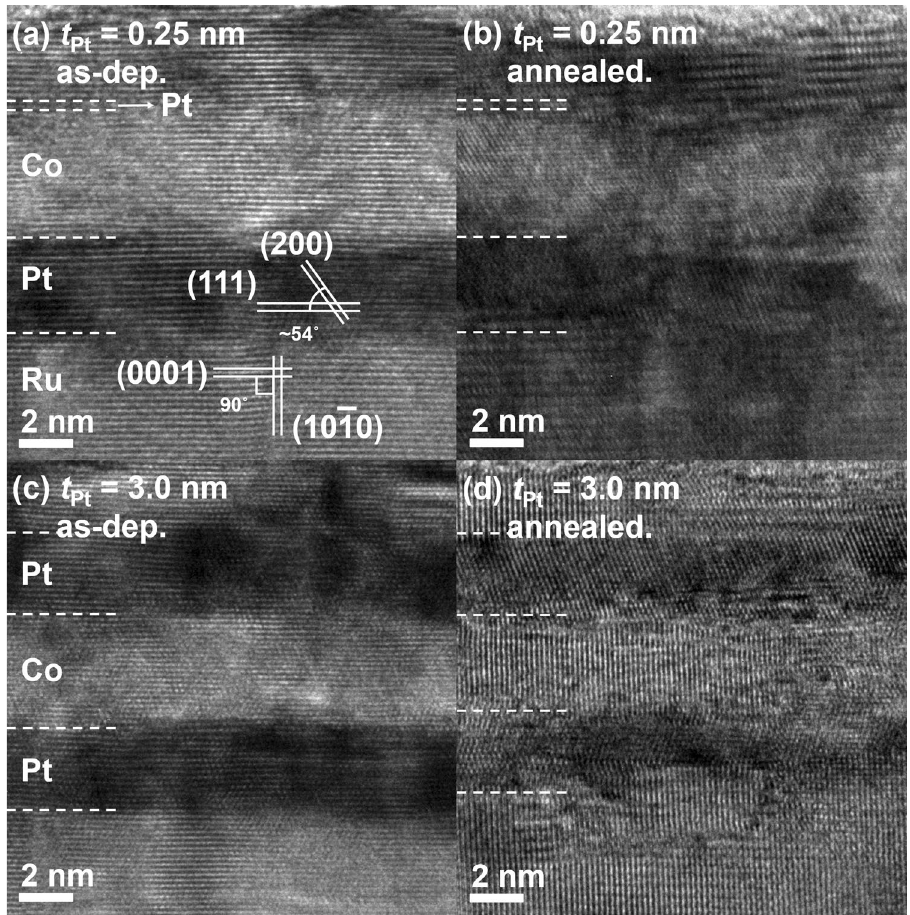
Figure 1. Cross-sectional HRTEM images of the [Pt/Co/Pt] structures with two t Pt values in both as-deposited and annealed samples. Results of the samples with ( a , b ) t Pt = 0.25 nm and ( c , d ) t Pt = 3.0 nm. Results for the ( a , c ) as-deposited samples and ( b , d ) annealed